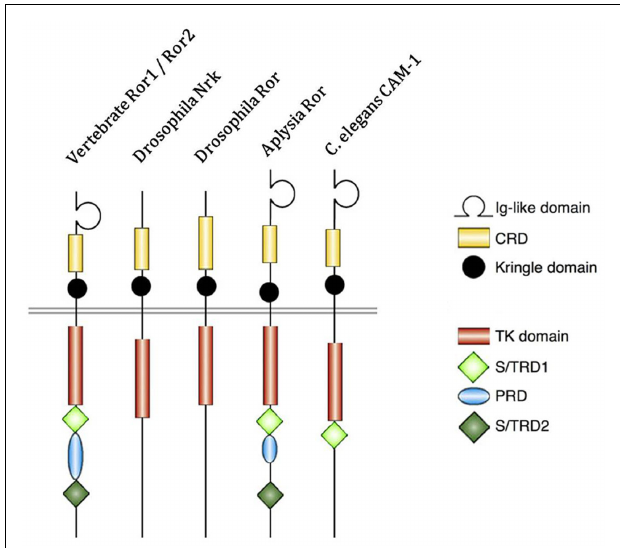
FIGURE 1 | Structure of receptor tyrosine kinase-like orphan receptor (ROR) in different species. Type 1 receptor tyrosine kinase evolutionarily conserved, co-receptor with Frizzled-2/4, with immunoglobulin (Ig) domain, cysteine-rich domain (CRD), and Kringle domain.The intracellular portion contains tyrosine kinase (TK) domain, proline-rich domain (PRD) flanked by Ser/Thr rich domains (S/TRD1 and 2; Green et al., 2008; Minami et al.,